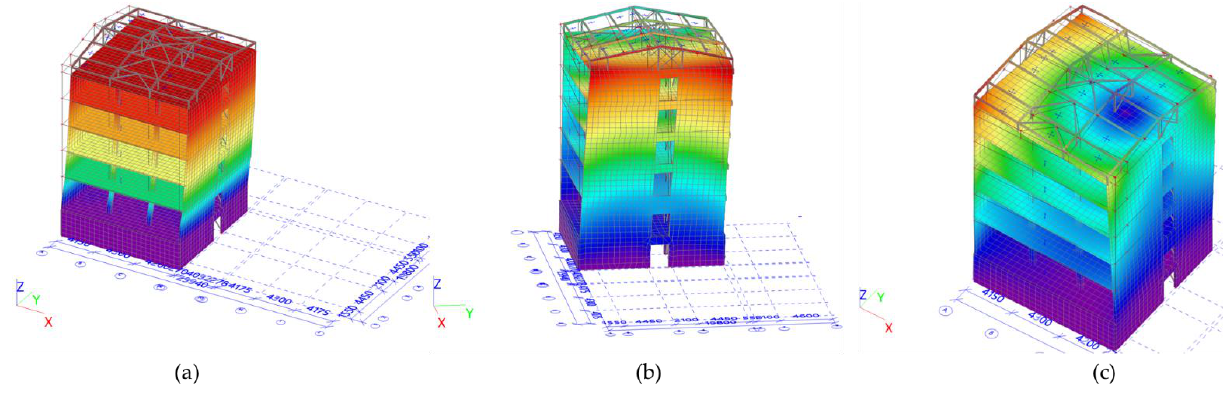
Figure 18. Eigenmodes of Section A: ( a ) translation X; ( b ) translation Y; ( c ) rotation (Z).